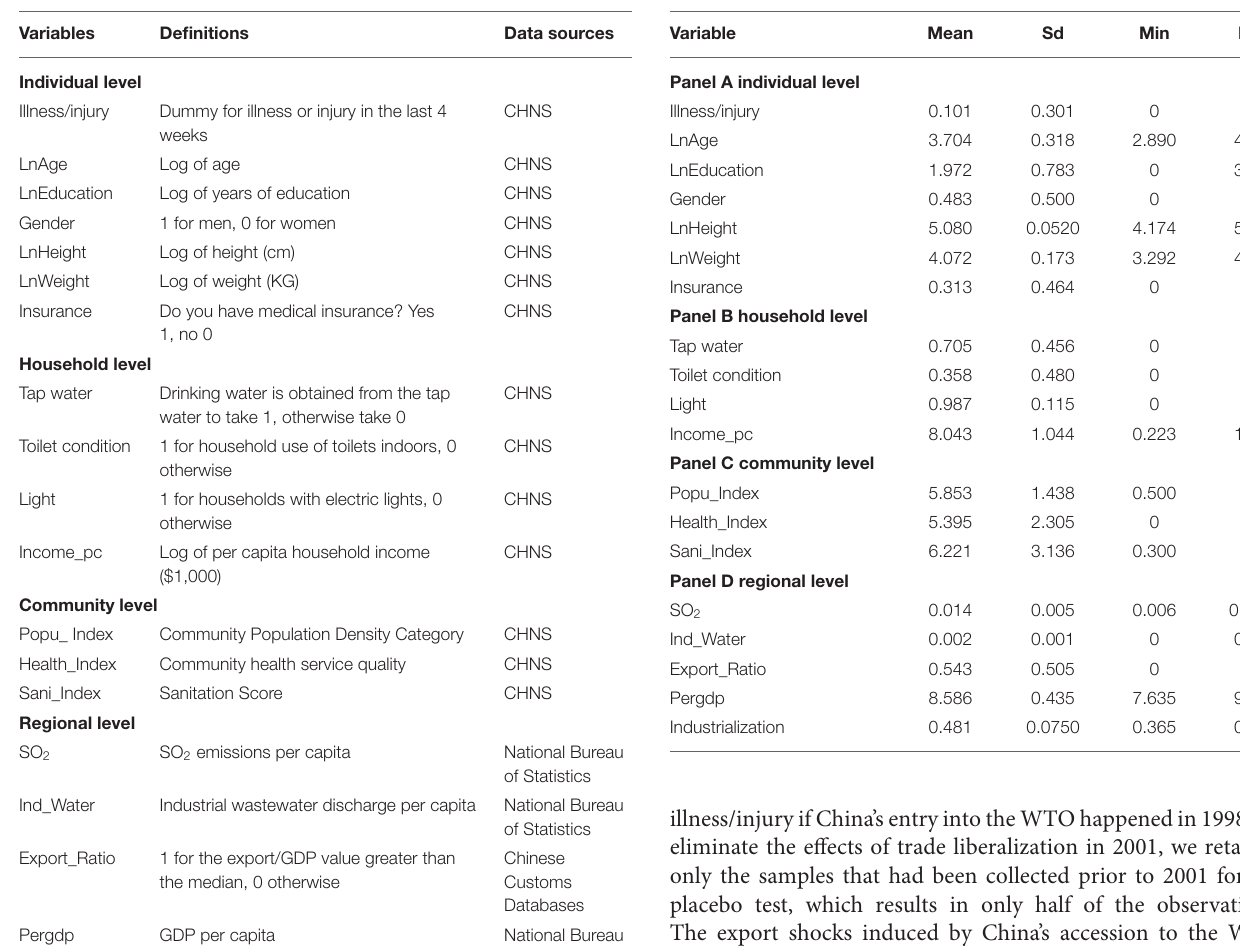
TABLE 1 | Definition of main variables and data sources. TABLE 2 | Summary statistics of the main variables.